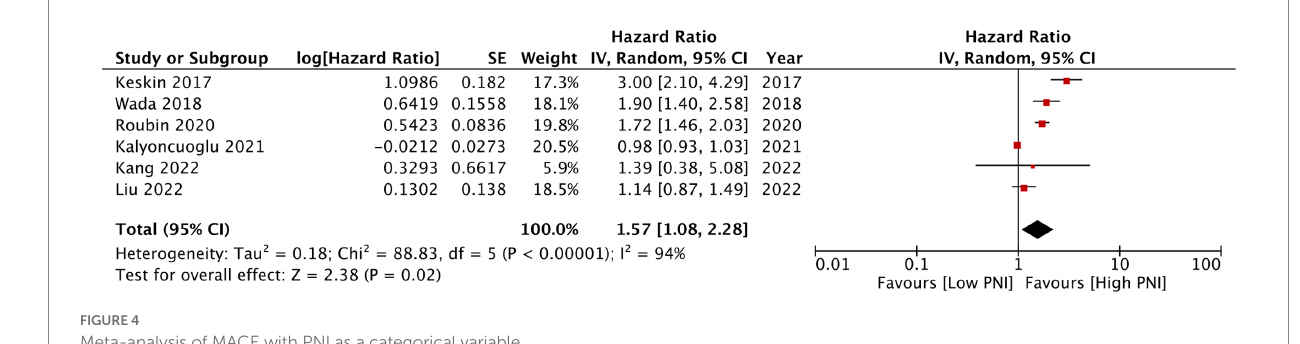
FIGURE 4 Meta-analysis of MACE with PNI as a categorical variable.